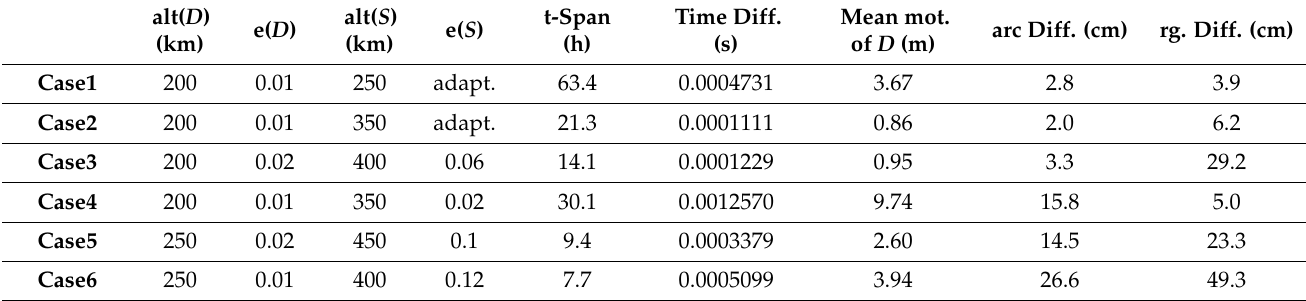
Table 1. Orbital elements of S and D and